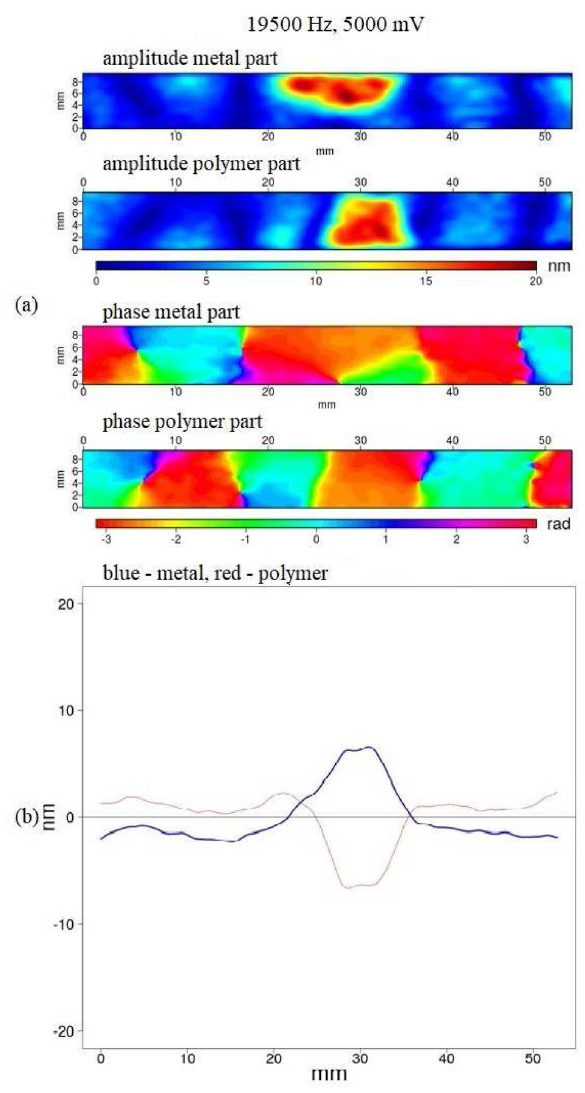
Figure 10. ( a ) Amplitude and phase pattern of a PLA_Al laminate sample with a bonding defect. ( b ) The amplitude data from ( a ), averaged along the y-direction; blue—aluminium, red—polymer. The colour bars indicate the amplitude in nm, the phase in rad. The size of the visible part of the sample is 54 × 9.5 mm